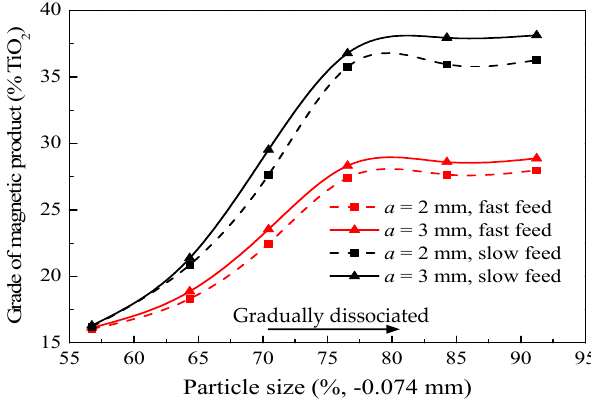
Figure 9. Effect of particle size on capture selectivity of single wire with different feed modes.